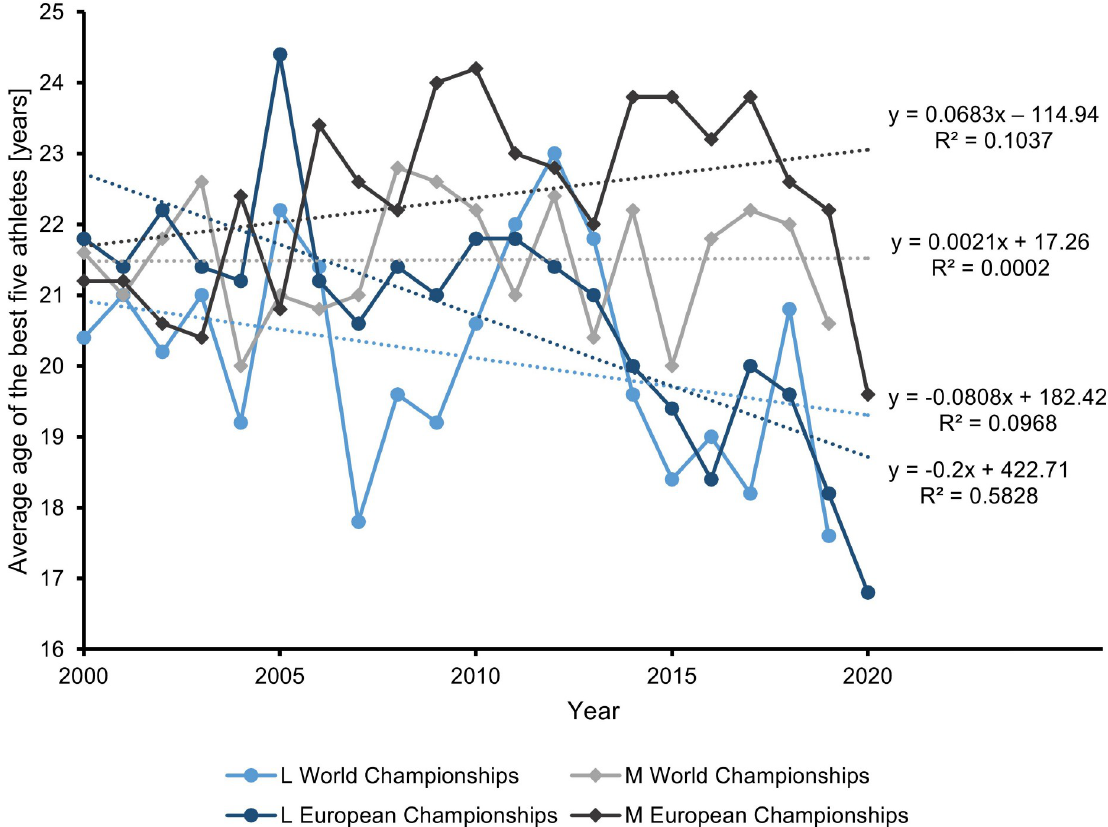
Fig 1. Trends of the average age. Trends of the average age of the best five female (L) and male (M) athletes each who competed in the singles categories at the European and World Figure Skating Championships since the year 2000. Regression analysis was performed to show trends over time. The regression function and the coefficient of determination (R 2 ) are shown for each group and indicate high variations in age.